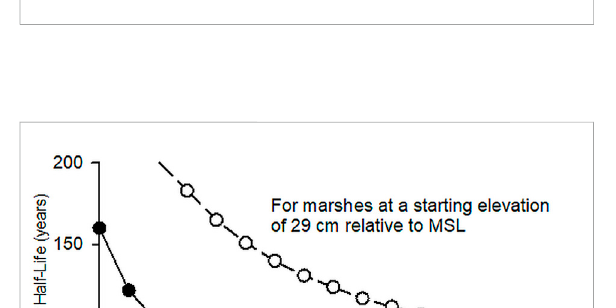
FIGURE 4 Predicted survival time of the vegetated marsh surface for different combinations of initial relative elevation (IRE) and centenary sea-level rise (CSLR). The range of IRE spans the vertical growth range of the vegetation. The range of CSLR sea-level rise spans the possible scenarios.